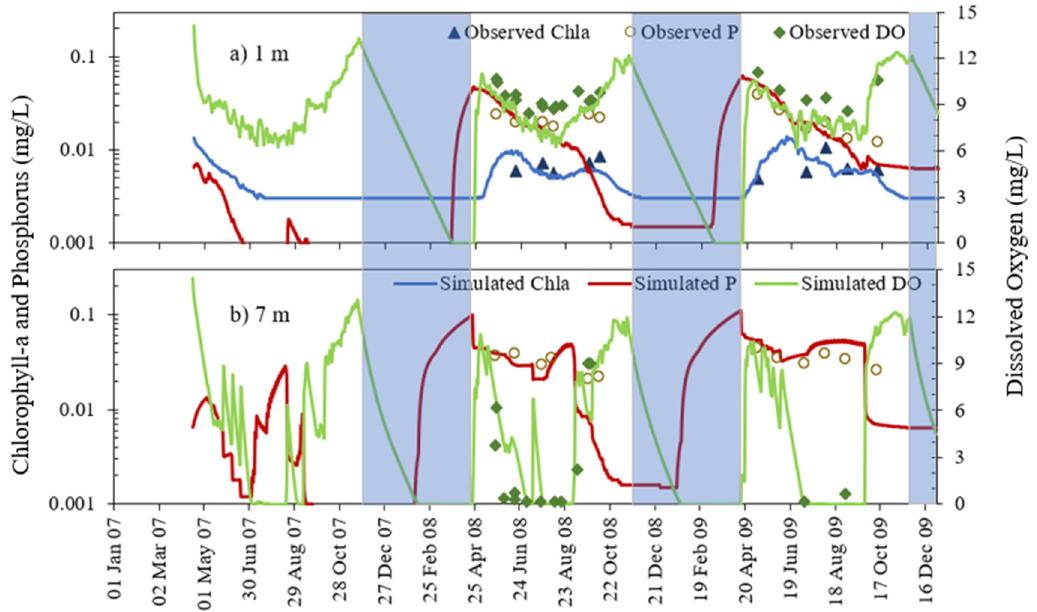
Figure 14. Simulated and observed chlorophyll-a, phosphorus, and dissolved oxygen concentration at ( a ) 1 m and ( b ) 7 m depth from the surface at Carrie Lake in 2007–2009 (blue shaded area represents the ice cover period).